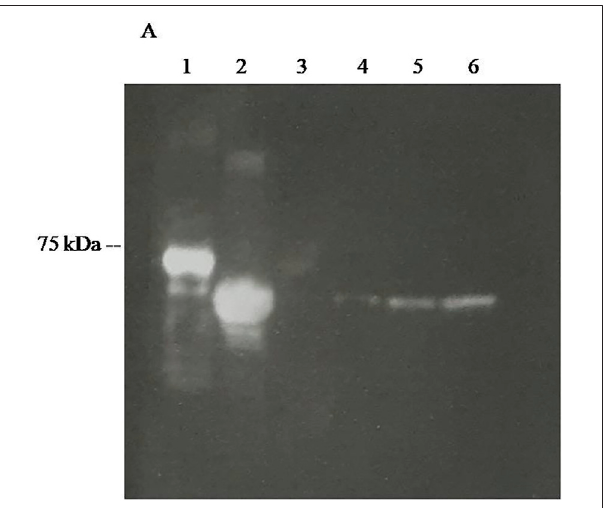
FIGURE 7 | CCD imaging of Western blots fi re fl y luciferases using polyclonal antibodies raised against Photinus pyralis fi re fl y luciferase revealed using ZZ-AmyLuc fusion protein as a secondary antibody and its assay solution: (1) ZZ-AmyLuc; (2) puri fi ed WT Amydetes vivianii fi re fl y luciferase;(3)10 ngofpuri fi ed Amydetesvivianii luciferase ; (4)50 ngofpuri fi ed Amydetes vivianii luciferase ; (5) 100 of puri fi ed Amydetes vivianii luciferase ; (6) 200 ng of puri fi ed Amydetes vivianii luciferase.